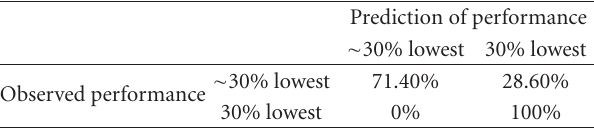
Table 1: Testing phase of the neural network predicting lowest 30% math